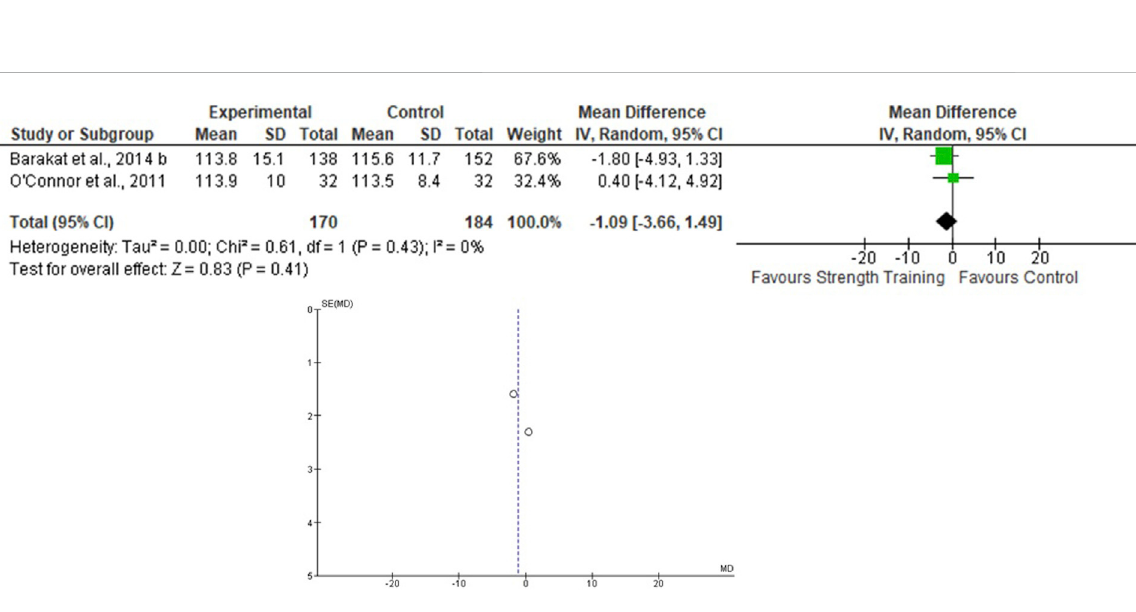
FIGURE 4 Effects of the ST on SBP in pregnant women and funnel plot for detecting bias and